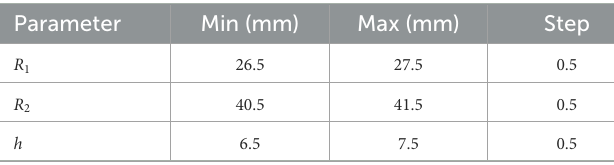
TABLE 7 Parameter ranges and steps for the third iteration of Point